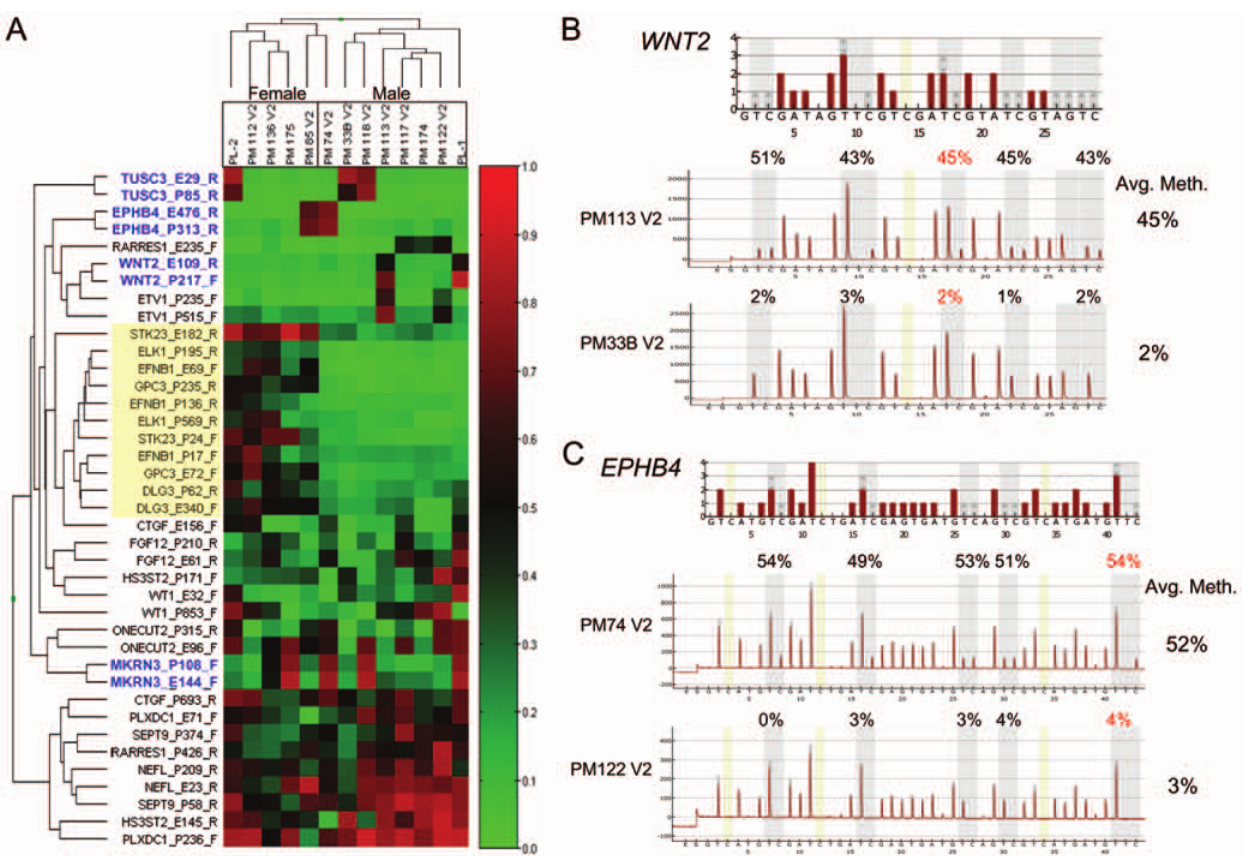
Figure 2. Genes exhibiting high interindividual variance in methylation values in the human placentas. (A) Heat-map of 19 genes with at least 2 probes having methylation variance greater than 1.5 SD from the mean. Probes and sample names are shown and with hierarchical clustering of beta values based on 1-r (Illumina Beadarray software). A beta value of zero (indicated in bright green) represents an unmethylated locus and one (indicated in bright red) represents a methylated locus. Probes for genes on the X chromosome are highlighted by a yellow box and the probes being further investigated here are bolded in blue. (B and C) Validation of variable methylation by bisulfite pyrosequencing for (B) WNT2 and (C) EPHB4 . CpG sites that are targeted by the Illumina probes are highlighted in red. One methylated sample and one unmethylated sample are shown for each gene. Reference pyrograms are shown on top.